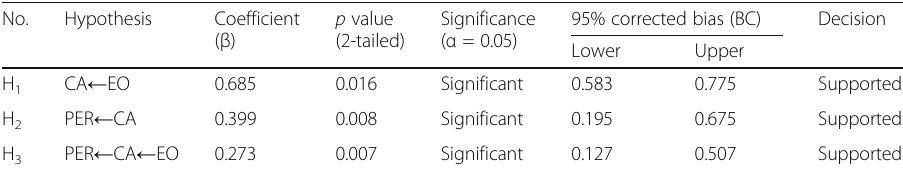
Table 3 Direct and indirect effects for firm growth measures